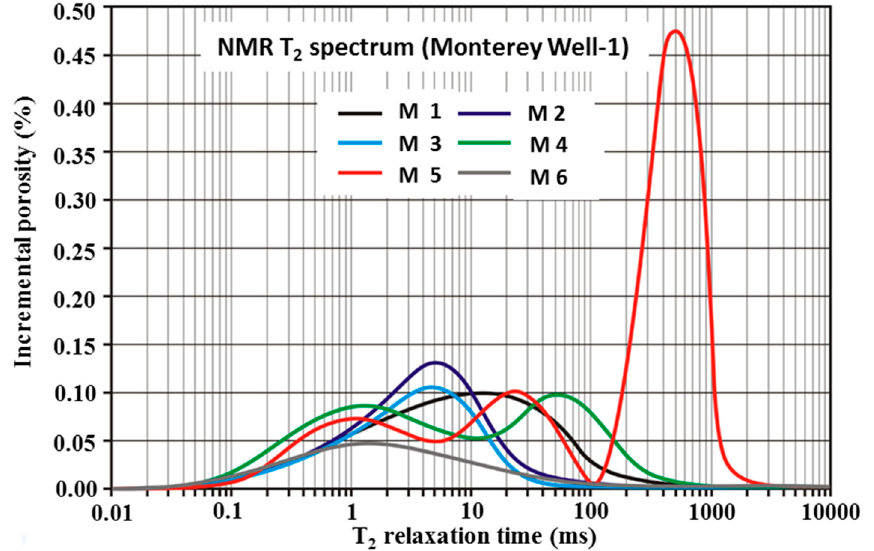
Figure 4. NMR T 2 spectrum for Monterey shales (i.e., M1–M6) collected from Well 1. Modified from Rivera [46].